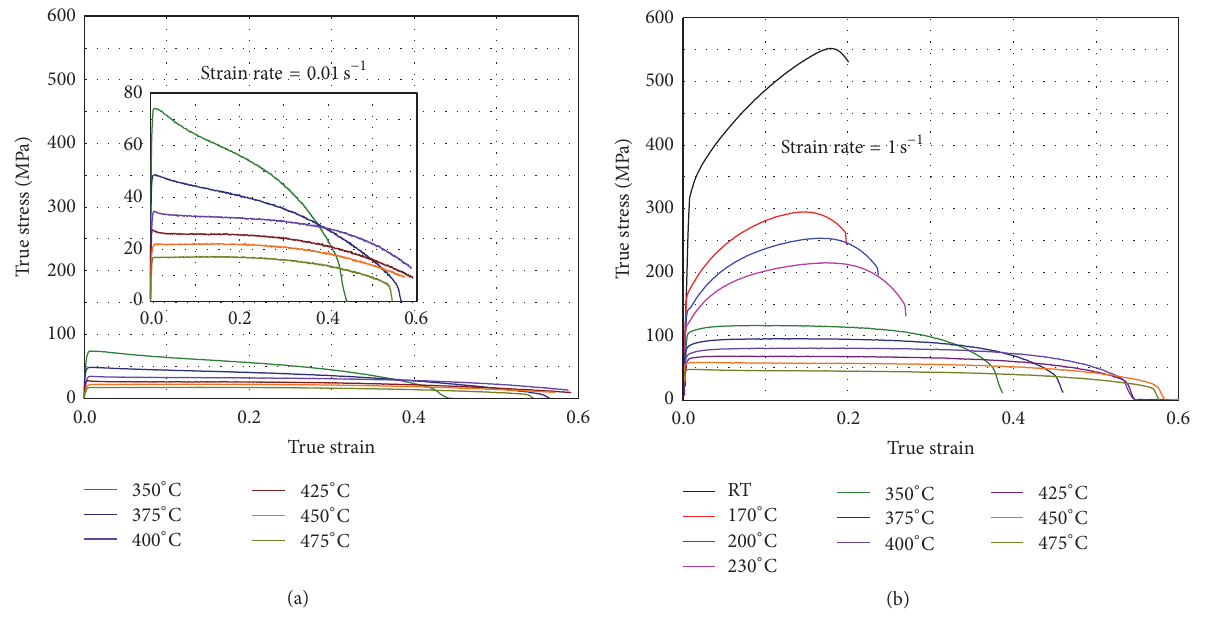
Figure 3: Hot flow curves of the as-received AW-7921-T4 sheet at strain rates of (a) 0.01 and (b) 1s −1